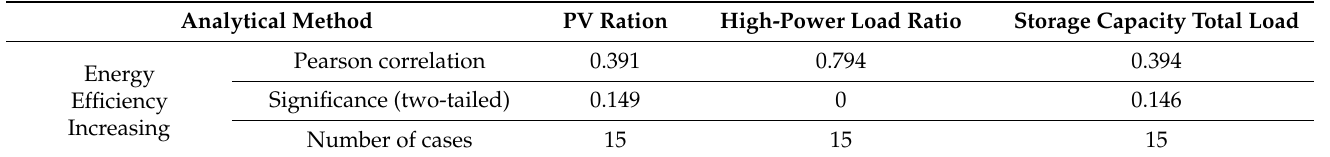
Table 8. Analysis of bivariate correlation of influencing factors.